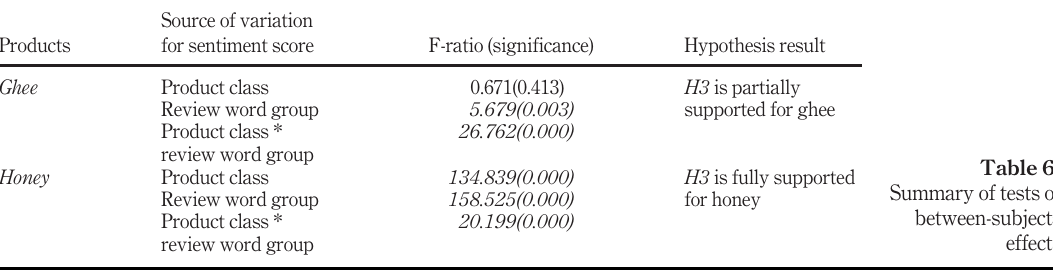
Table 6. Summary of tests